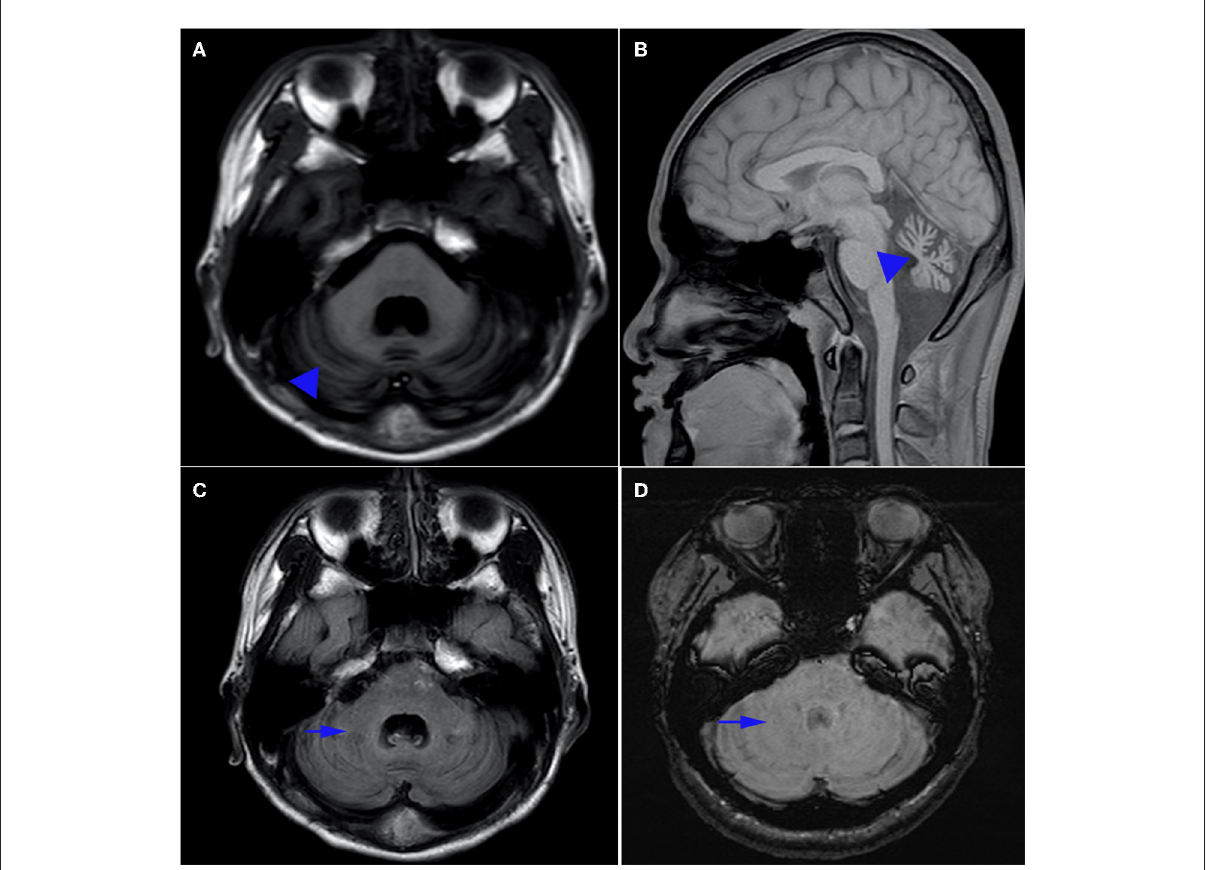
FIGURE1 Brain MRI. Axial T1-weighted (A) and sagittal T1-weighted (B) magnetic resonance images of the patient. Note the presence of pure cerebellar atrophy and low cerebellar dentate nucleus signal, without involvement of the brain stem and cerebral cortex. Hyposignal in the dentate nucleus can be seen on T1 (C) , but is absent on susceptibility weighted imaging (SWI) (D)